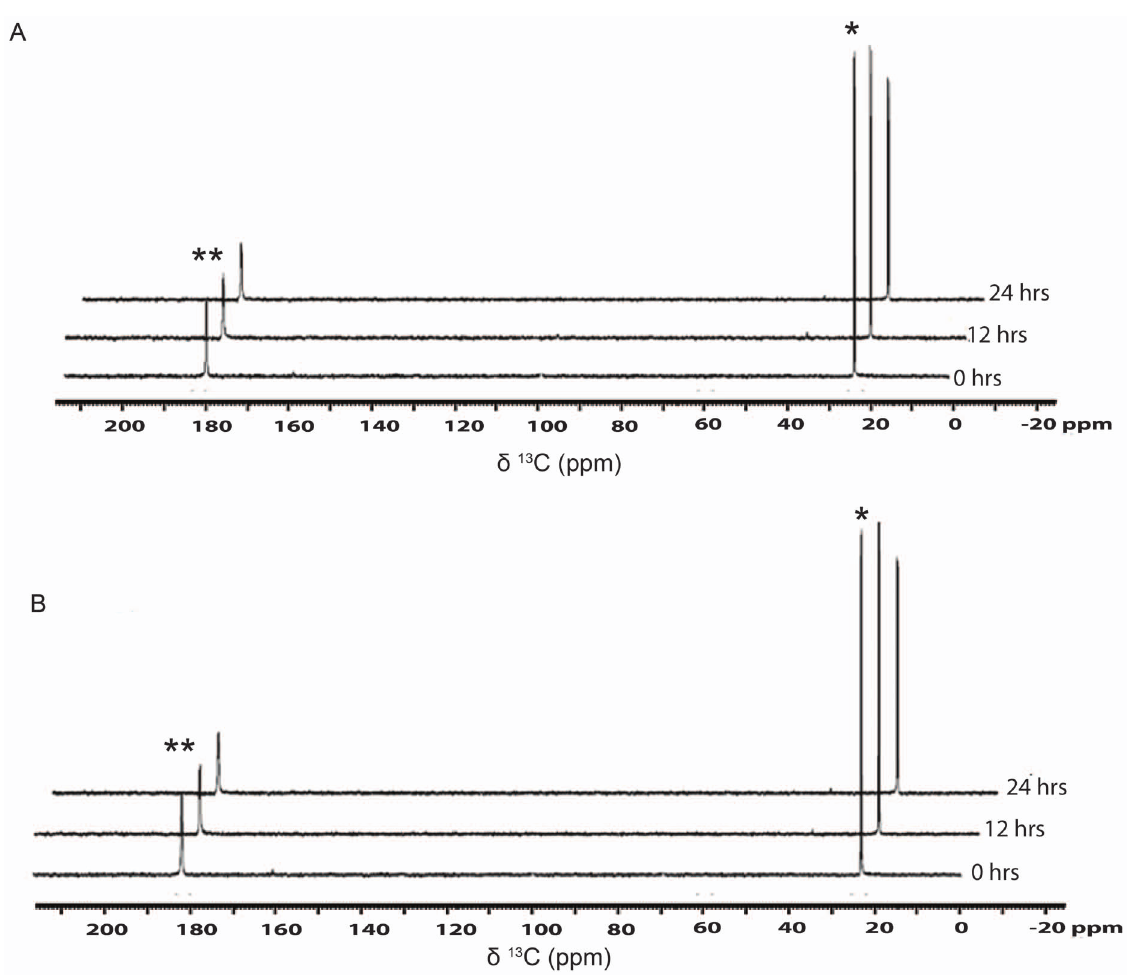
Figure 5. Assimilation kinetics of [1, 2- 13 C]-acetate during heterotrophy and mixotrophy in the presence of mitochondrial uncoupler CCCP. Assimilation kinetics of acetate and metabolite formation by C. reinhardtii , during (A) heterotrophy and (B) mixotrophy following the addition of [1, 2- 13 C]- acetate to the TP medium containing CCCP (20 m M). CCCP stock (100 mM) was prepared in DMSO from where 20 m M CCCP was achieved. (The signs * and ** represent methyl and carboxyl peaks, respectively, of [1, 2- 13 C]-acetic acid).